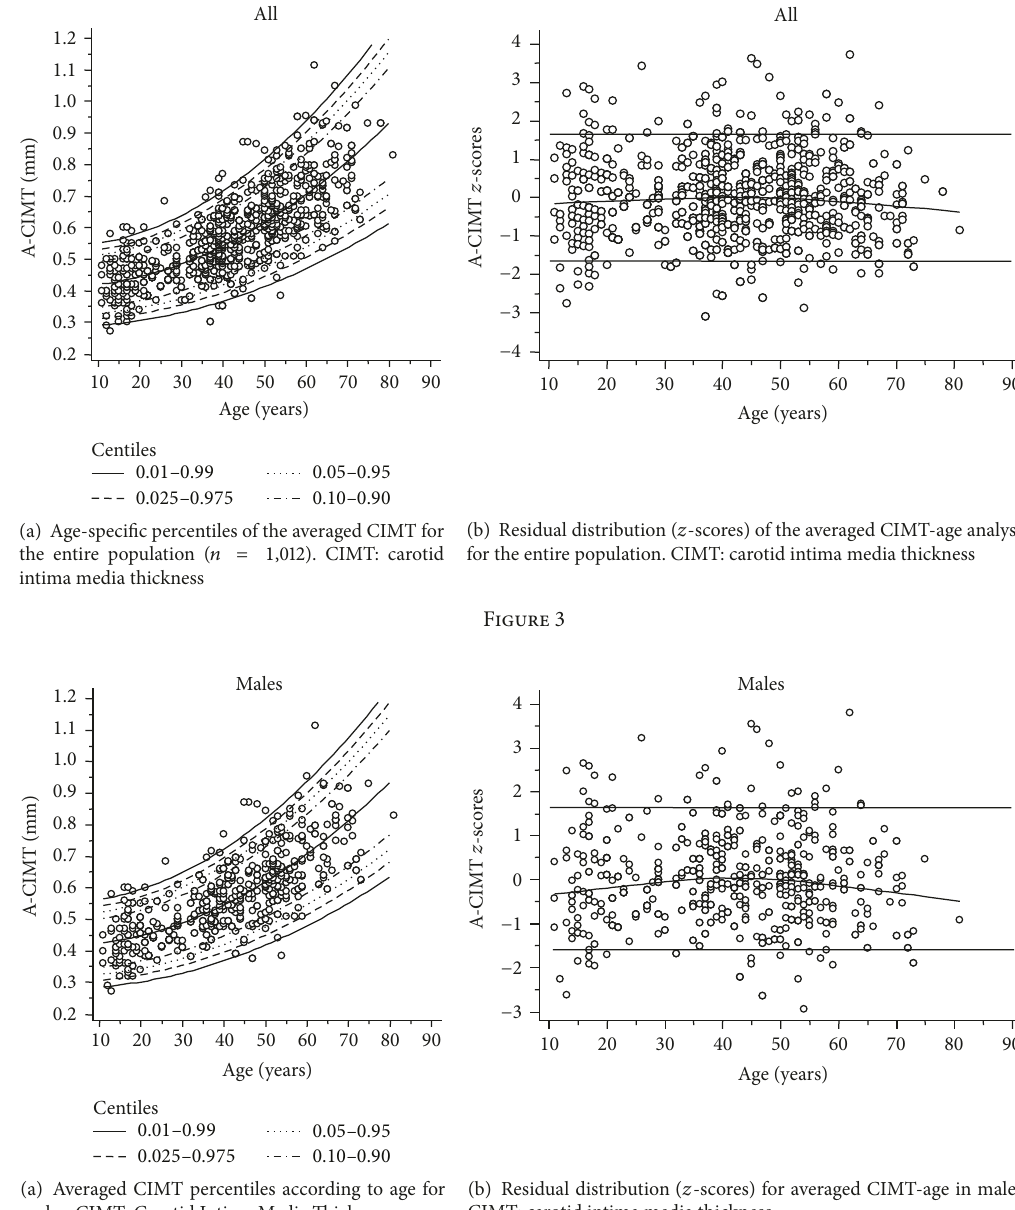
(b) Residual distribution (𝑧 -scores) for averaged CIMT-age in males. CIMT: carotid intima media